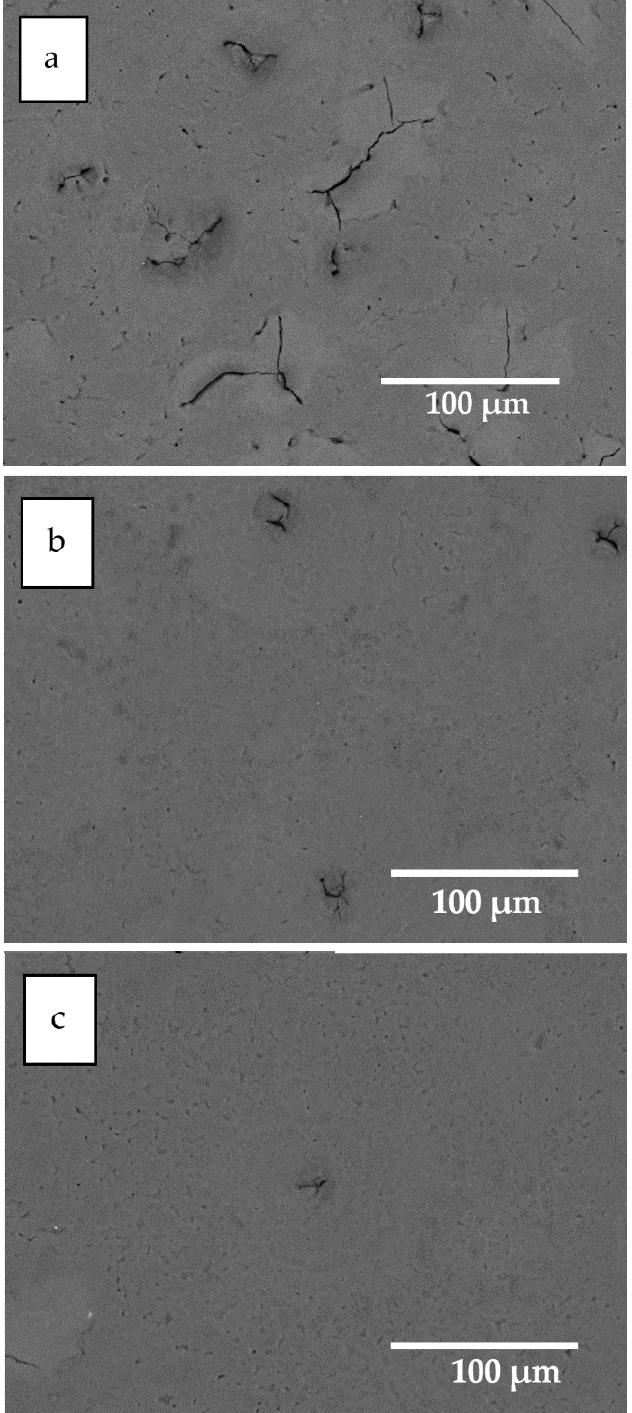
Figure 4. SEM morphology micrographs of the Al–20Si–5Mg–0.7Ce alloy surface irradiated using HCPEB. ( a ) 5 pulse specimen, BSE image; ( b ) 15 pulse specimen, BSE image; ( c ) 25 pulse specimen, BSE image.